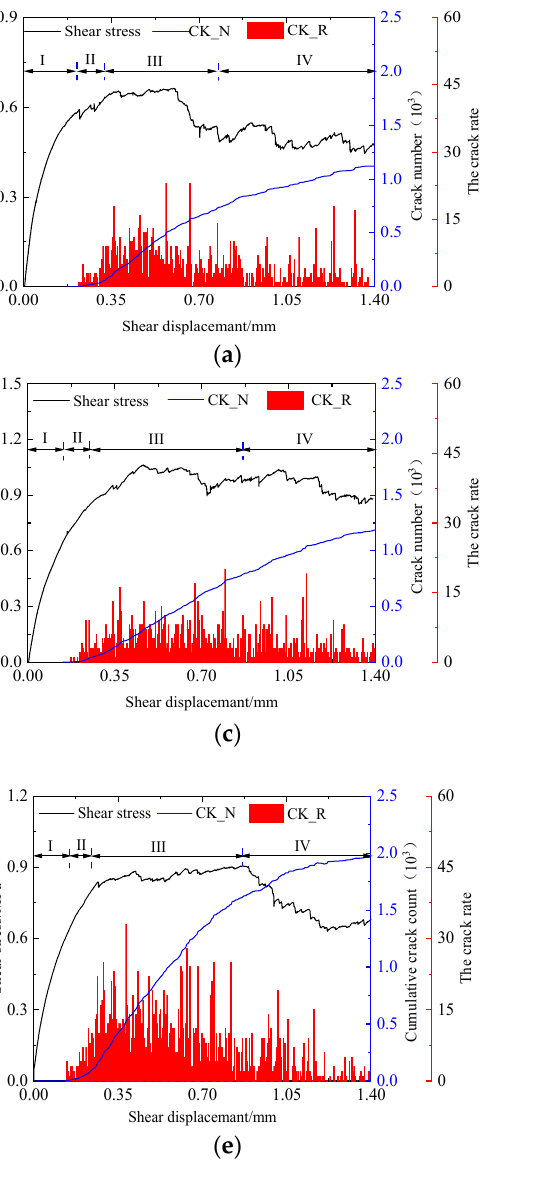
Figure 19. In the direct shear test, the shear stress, acoustic emission impact number of natural gas hydrate deposits under different conditions, and the cumulative acoustic emission impact number of specimens in the shear process are as follows: ( a ) S h = 20%, σ w = 0.9 MPa, ( b ) S h = 20%, σ w = 1.2 MPa, ( c ) S h = 20%, σ w = 1.5 MPa, ( d ) S h = 30%, σ w = 0.9 MPa, ( e ) S h = 30%, σ w = 1.2 MPa, ( f ) S h = 30%, σ w = 1.5